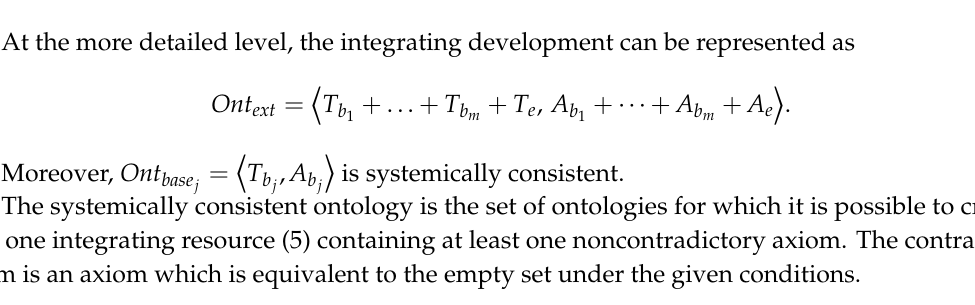
Figure 3. Integrative extensive development of ontology.